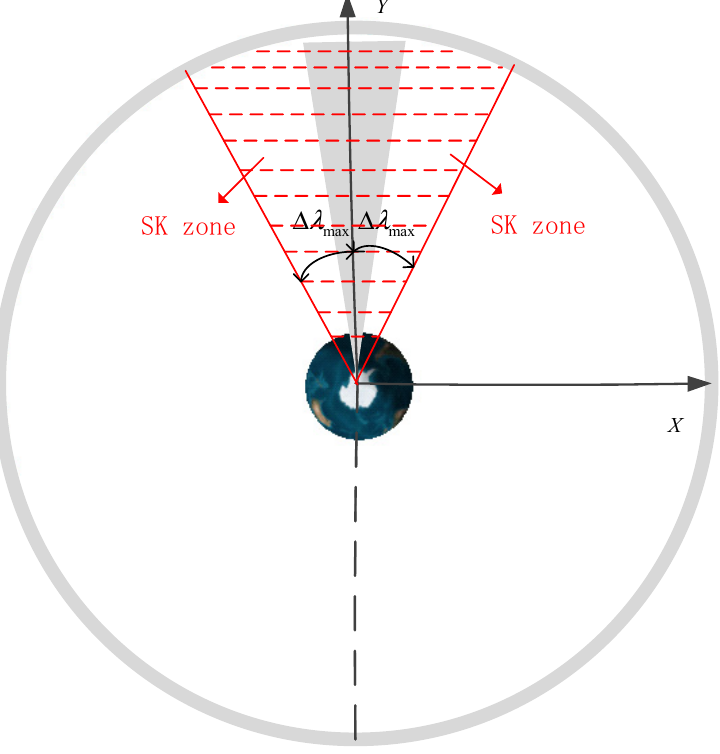
Figure 5. The range for NSSK zone of the GEO satellite.